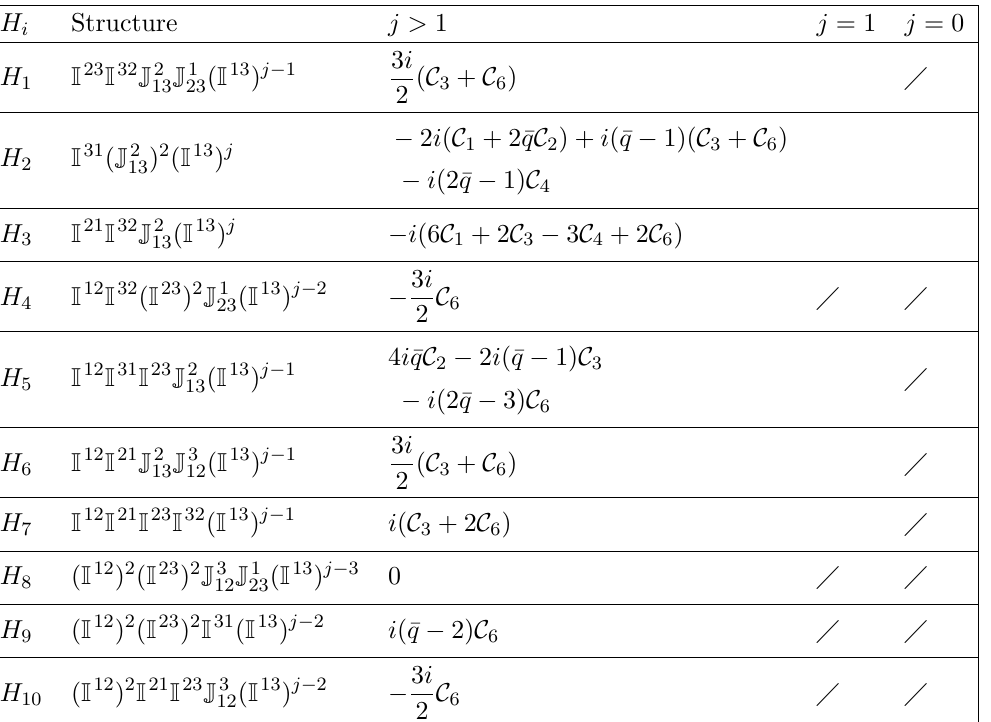
Table 24 . Expansion of the supersymmetric correlator in the component has spin ( 1 ; 1 j ). The unbarred entries in the last two columns can be obtained by setting the absent 2 2 coe(cid:14)cients to zero (see caption of table